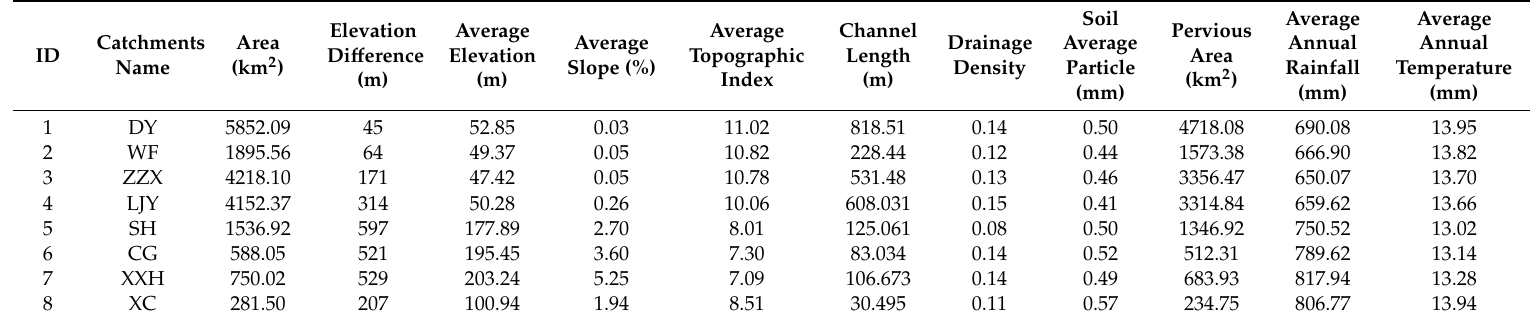
Table 1. Major characteristics of the study catchments.